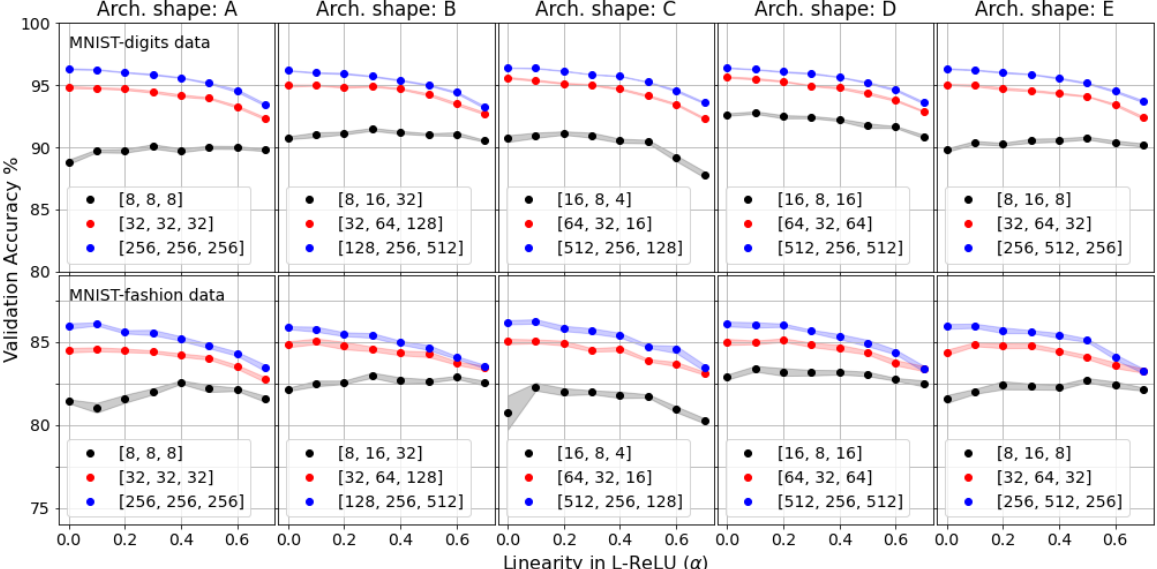
Figure 2. The maximum validation accuracy as a function of the linearity factor ( α ) for models with five network architecture shapes (Arch. shapes A–E) and three network widths (see Table 1). Models were trained on 20,000 MNIST-digits images ( upper panel ) and 20,000 MNIST-fashion images ( lower panel ). For all the models used in this test, the number of nodes used in each hidden layer is shown within the square brackets in each sub-figure in the order of number of nodes used in first, second and third hidden layers,